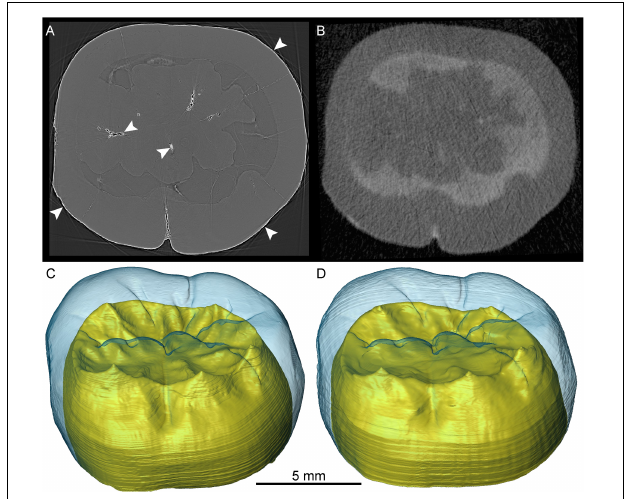
FIGURE 8 | SR- µ CT- (A) and n- µ CT-based (B) transverse virtual cross-sections of the crown of the lower molar Sangiran 7–20. The corresponding 3D surfaces are shown in (C,D) , respectively, where the blue enamel in semi-transparency reveals details of the EDJ and the crown dentine is rendered in yellow. The white arrows in (A) show the bright fringes produced by the phase contrast effect.